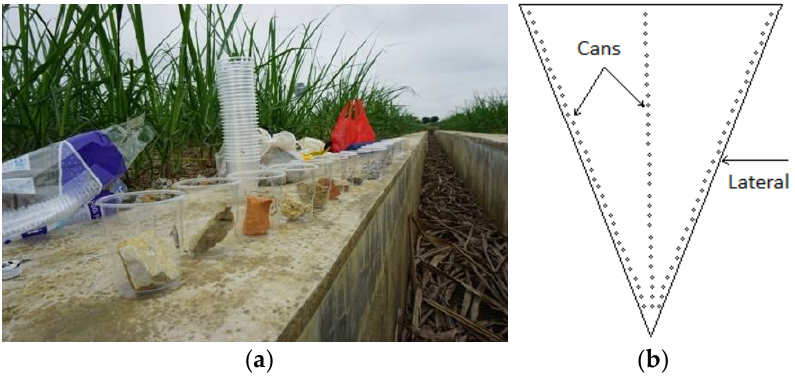
Figure 5. ( a ) Cups numbered and placed in ( b ) 3 rectilinear pattern for uniformity